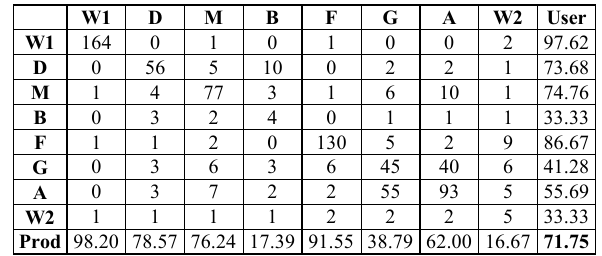
Table 2. Confusion matrix for Scenario 1. Note: W1=Water, D=Developed, M=Mining, B=Barren, F=Forest, G=Grassland, A=Agriculture, W2=Wetland.